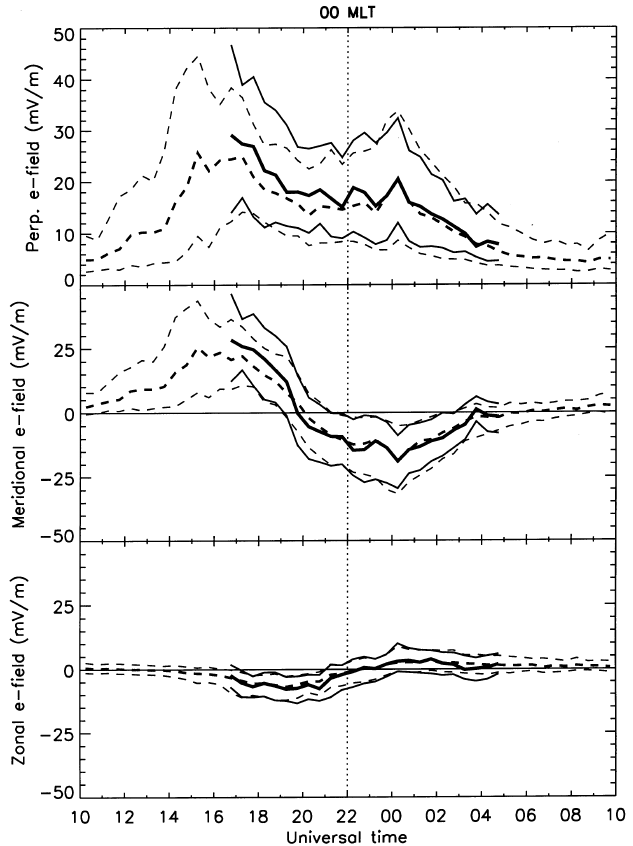
Fig. 2. UT variation of the magnitude of the field-perpendicular electric field ( upper panel ), its north-south component ( middle panel ; positive northwards) and its east-west component ( lower panel ; positive eastwards). The format is identical to that of Fig. 1